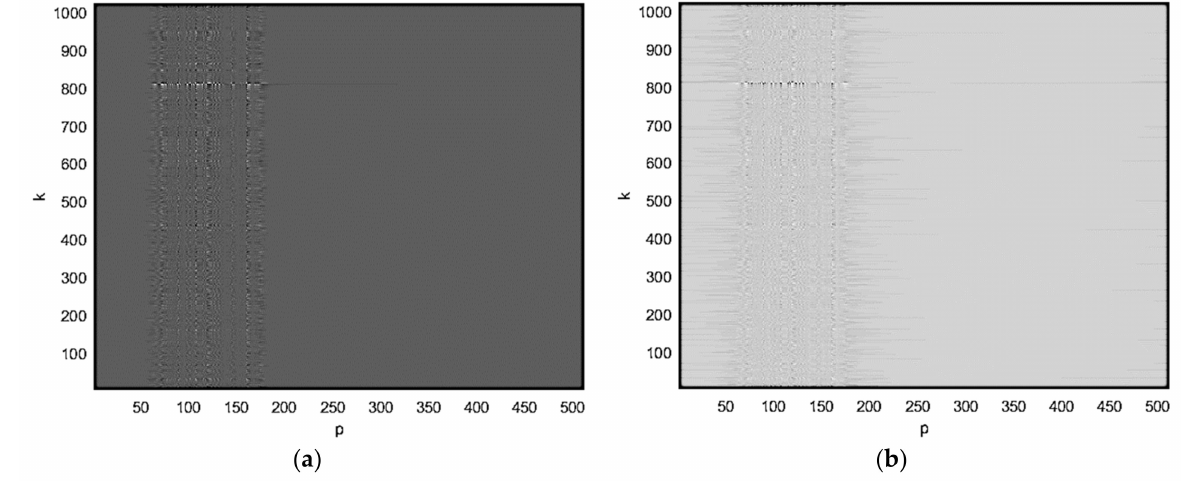
Figure 5. BFISAR complex image after azimuth compression and shifting: ( a ) real and ( b ) imaginary parts.